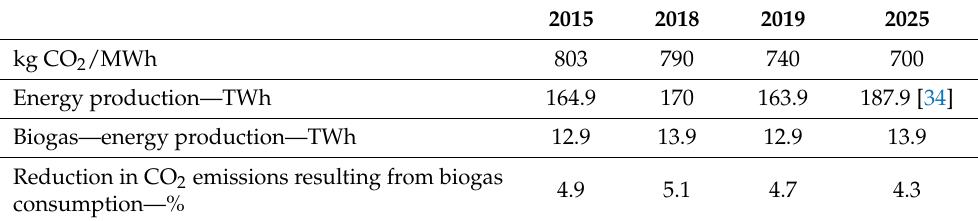
Table 4. The impact of biogas on the reduction in CO 2 emissions in Poland. Source: Own